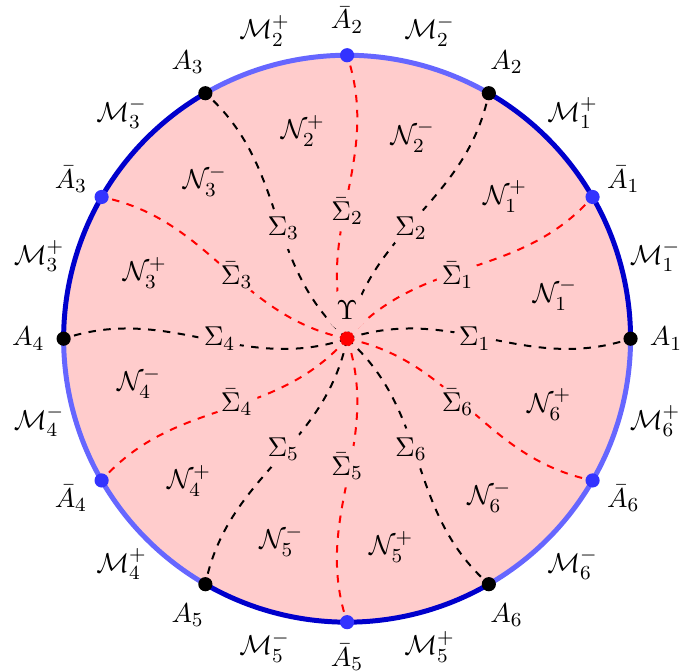
Figure 7. The bulk corresponding to F k . Assuming the symmetries of the boundary continue to hold in the bulk, we may decompose it as shown. (The case shown is for k = 3.)